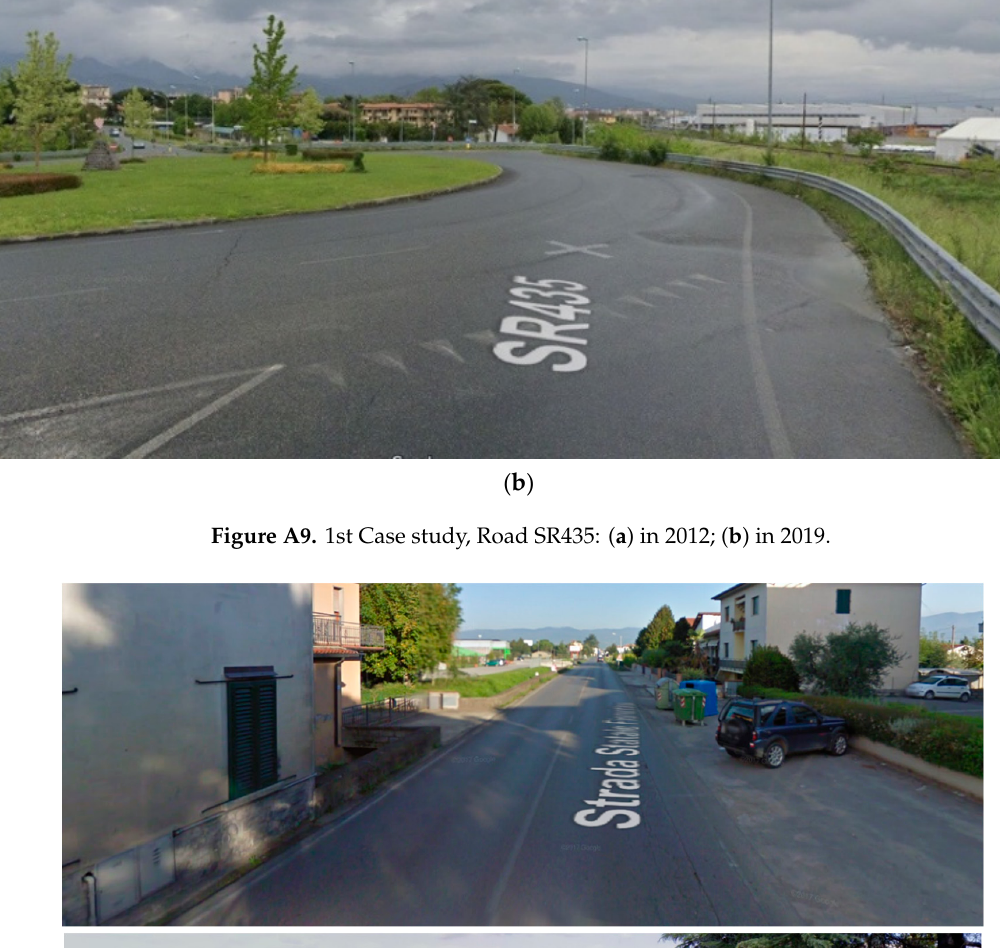
Figure A9 . 1st Case study, Road SR435: ( a ) in 2012; ( b ) in 2019.